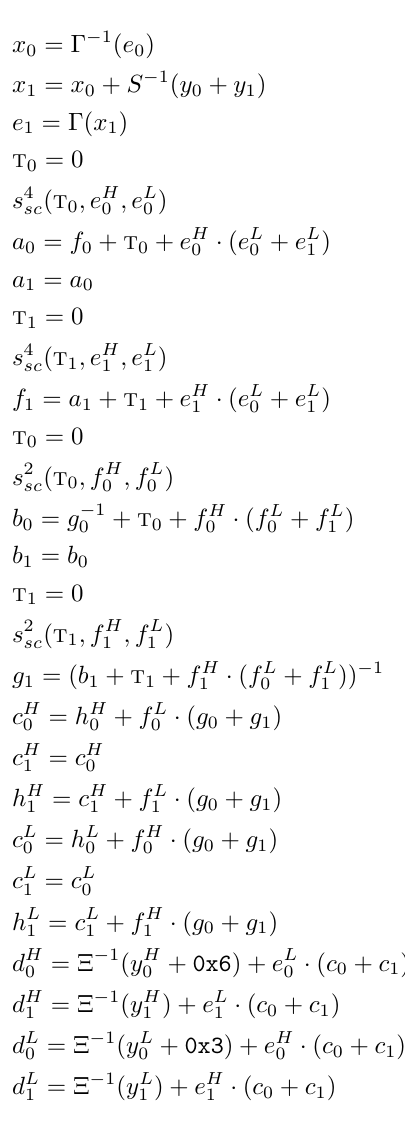
Figure 9: Inverse computation to show that Circuit 8.b is a